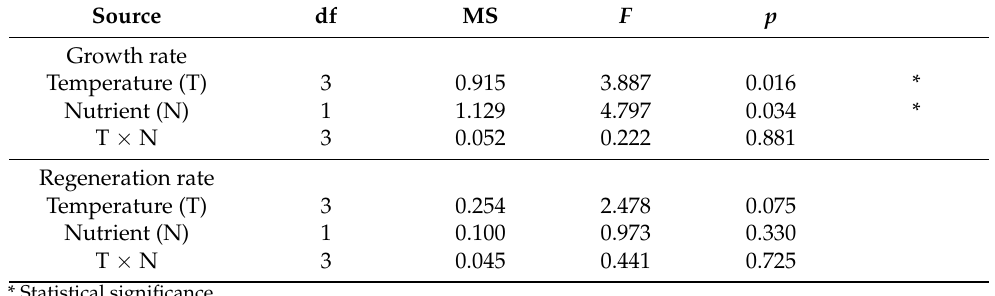
Table 2. Results of two-way ANOVA on the effects of temperature and nutrient availability on the relative growth and regeneration rates of Sargassum fusiforme holdfasts.